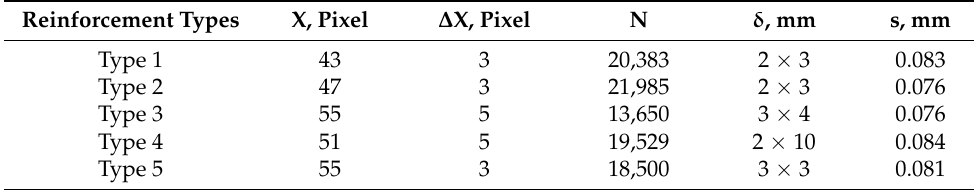
Table 1. Correlation analysis parameters for polymeric composite specimens with various reinforce- ment types.